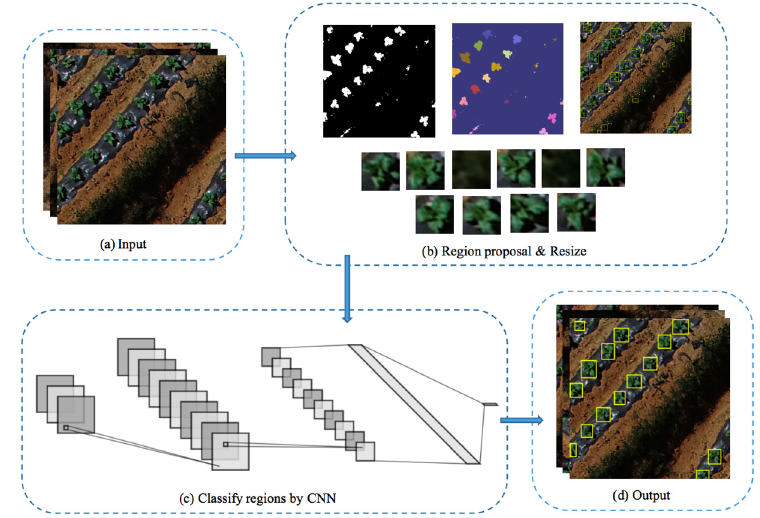
Figure 1. An overview of our proposed model. ( a ) The model takes in an input, ( b ) regions are proposed by our candidate selecting algorithm which is detailed in Section 3.1, ( c ) proposed regions are classified by a trained network which is illustrated in Section 3.2, ( d ) the model outputs the positive regions.